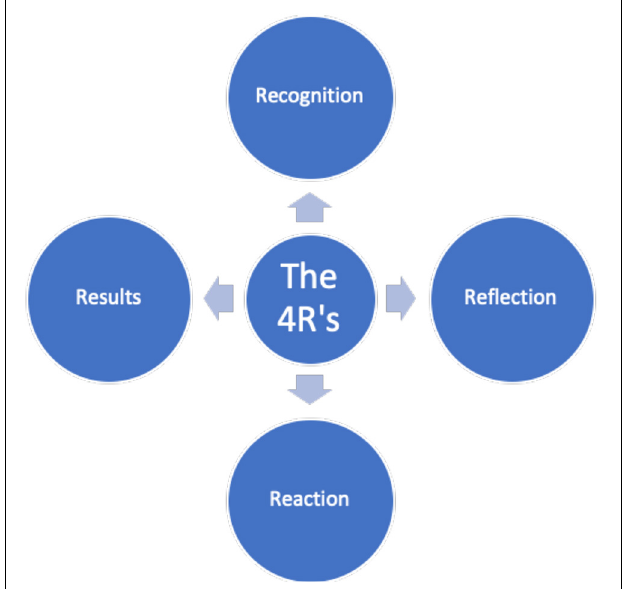
FIGURE 1 | Four R’s professional inquiry